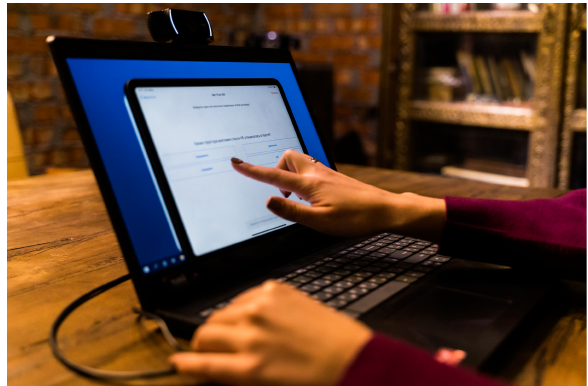
Figure 2. Reading and choosing answers to questions in the developed Oken Reader application on the iPad. The choice was made by tapping the button with one of the answer